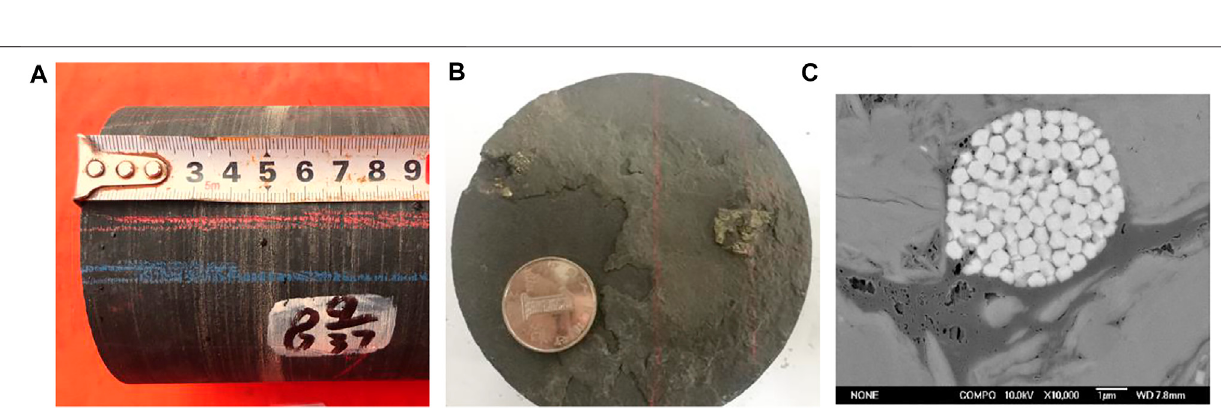
Frontiers in Earth Science |